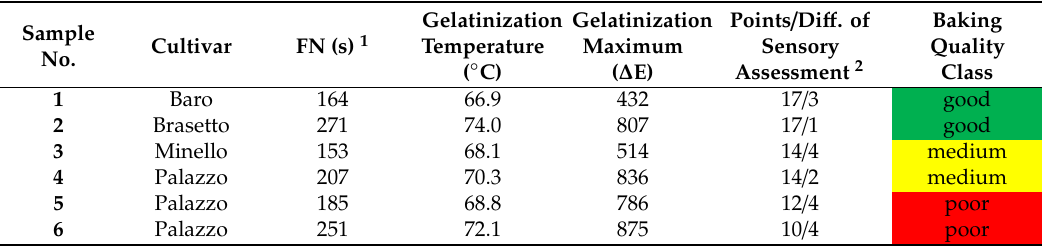
Table 1. Selected rye flours and their main characteristics according to the standard baking